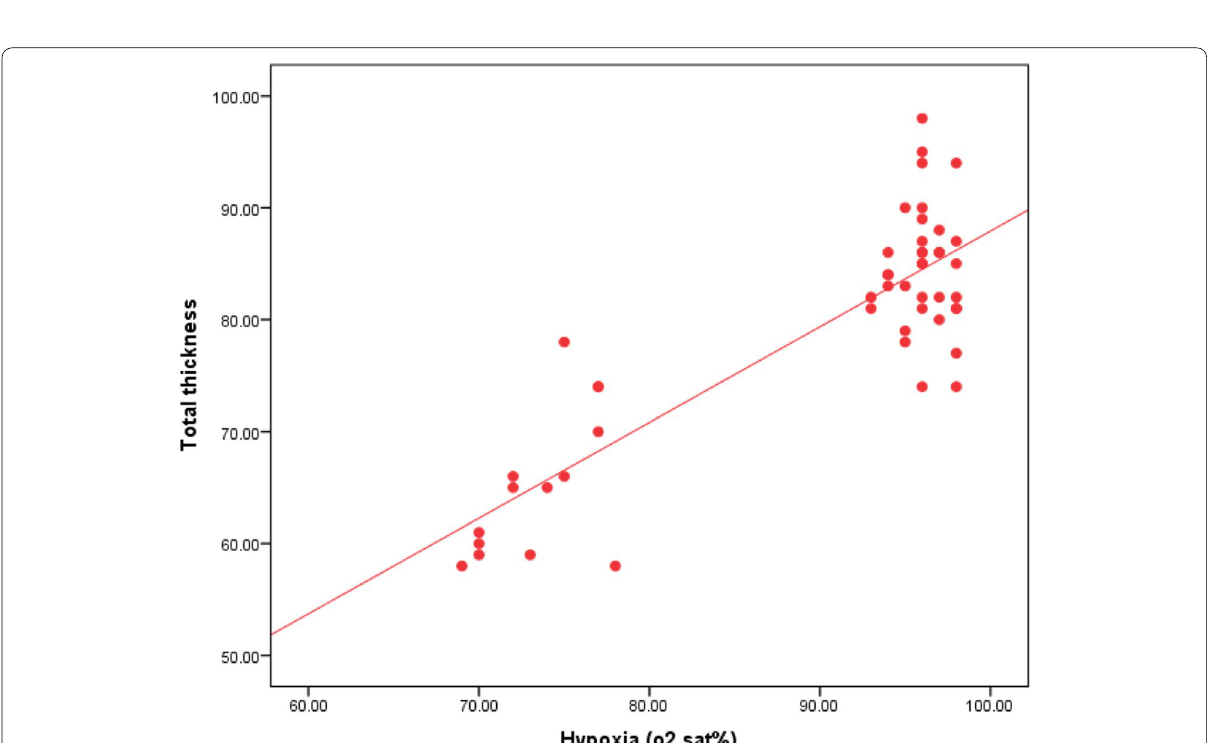
Fig. 2 Correlation between oxygen saturation of the patients and the average total thickness of the retinal nerve fiber